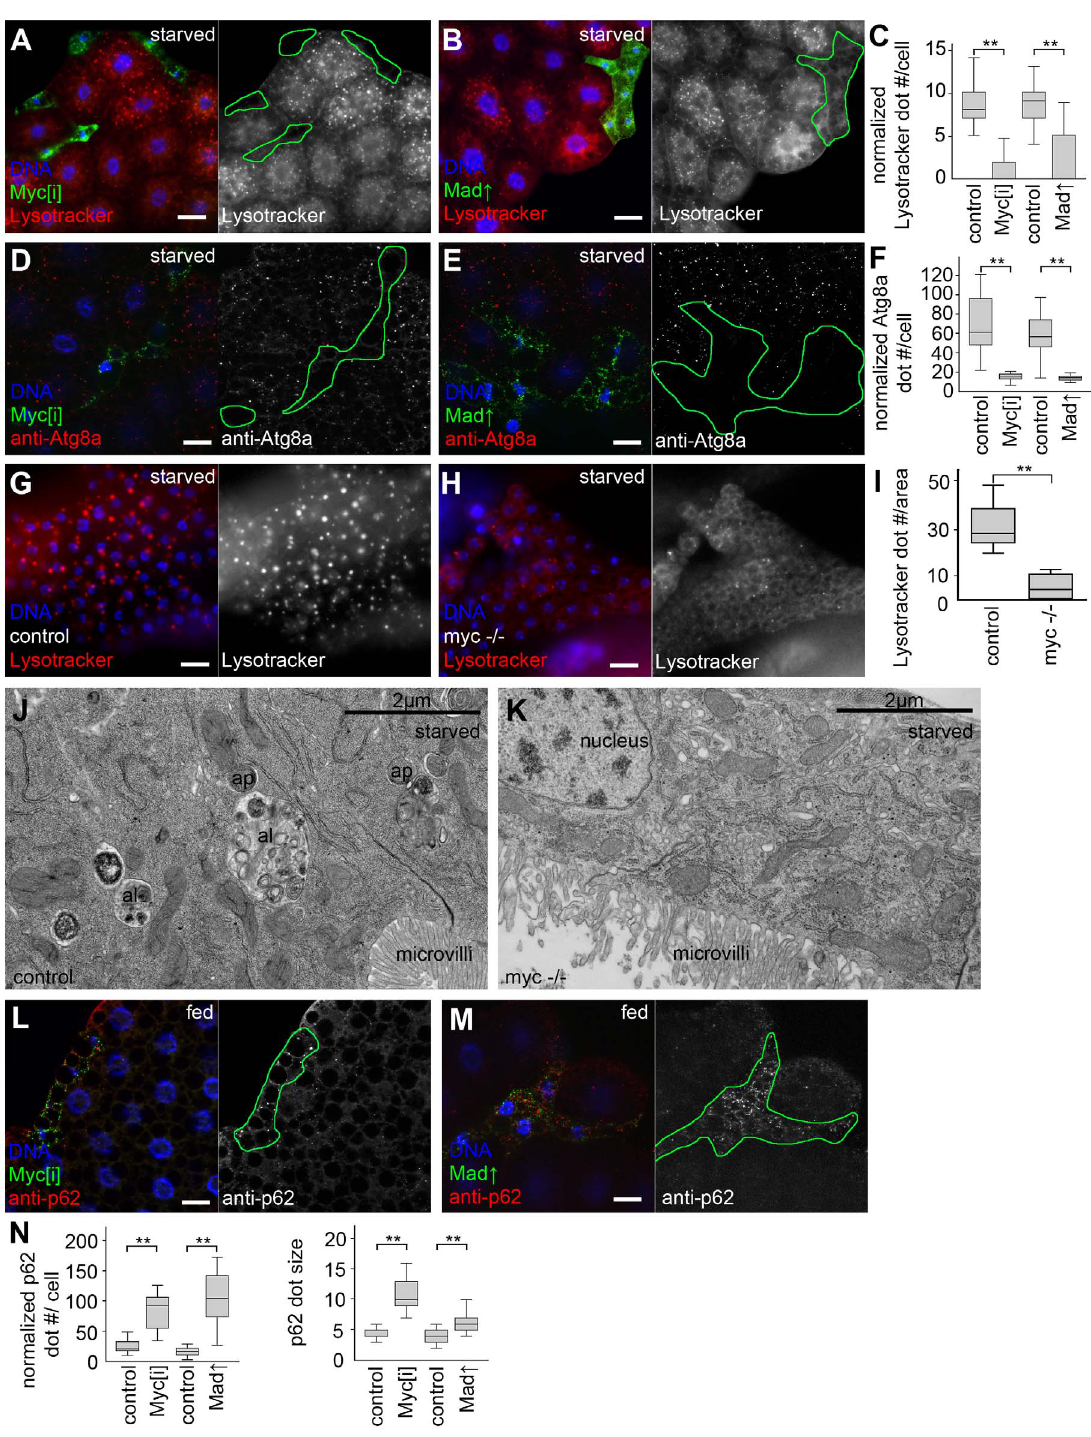
Figure 1. Myc is necessary for starvation-induced autophagy in Drosophila. (A) Myc depletion in LAMP1-GFP marked fat body cell clones inhibits starvation-induced punctate Lysotracker staining, compared to surrounding control cells that do not express GFP. Mid-L3 stage larvae were analyzed in all fat body experiments unless noted otherwise. (B) Overexpression of Mad also blocks Lysotracker dot formation in cells marked by LAMP1-GFP. (C) Quantification of data presented in panels A and B, n=7 for all genotypes. (D) Starvation-induced punctate endogenous Atg8a staining is inhibited in Myc RNAi cells marked by LAMP1-GFP expression, compared to neighboring control tissue. (E) Forced expression of Mad also decreases Atg8a dot formation. (F) Quantification of data presented in panels D and E, n=6 for all genotypes. (G) Starvation leads to the formation of Lysotracker-positive autolysosomes in fat body cells of control L1 stage larvae. (H) A near-complete block of Lysotracker puncta formation is seen in Myc null mutant L1 stage larvae. (I) Quantification of data presented in panels G and H. (J) Double-membrane autophagosomes (ap) and dense autolysosomes (al) degrading sequestered cytoplasmic cargo are observed in midgut cells of control L1 stage larvae. (K) No autophagic structures are seen in midgut cells of L1 stage Myc null mutant larvae. (L) The selective autophagy cargo p62 accumulates in Myc RNAi cells (marked by LAMP1-GFP